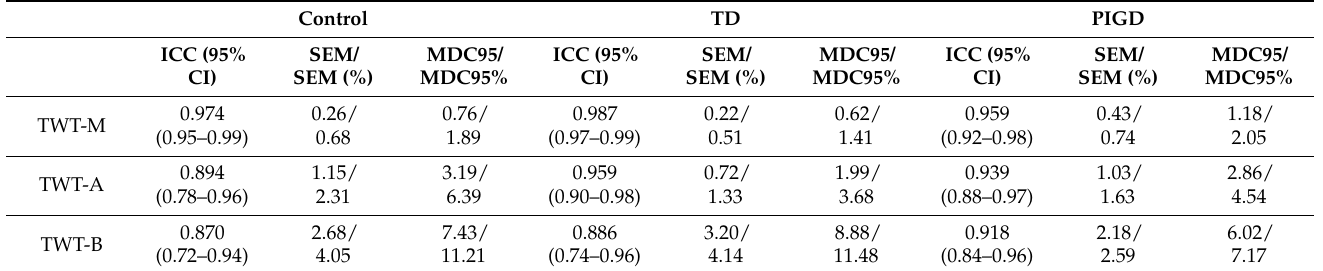
Table 4. Intra-class correlation (ICC) and absolute inter-trial reliability (SEM) across the three TWT